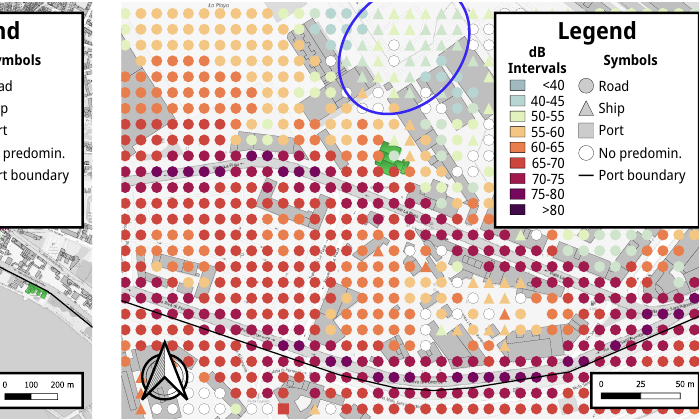
Figure 4: Detail of the I-NSP map of the port of Cagliari for L DEN indicator.